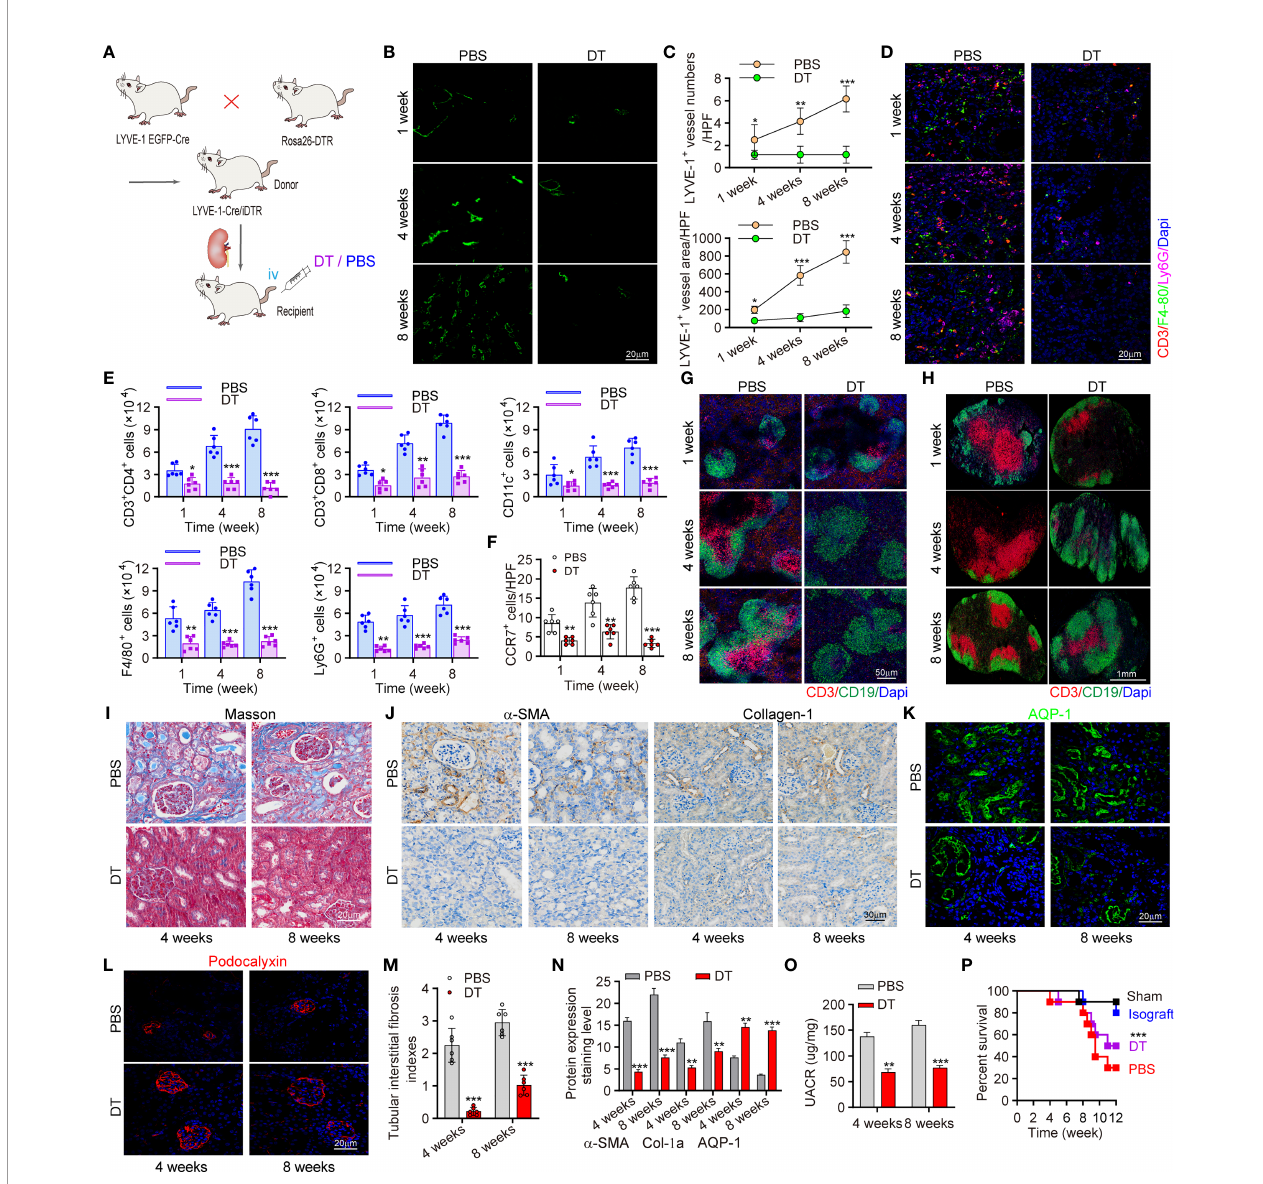
FIGURE 4 | Conditional knockout of LVs attenuated CCR7+ cells expansion and ameliorates allograft function. (A) Scheme showing the establishment of conditional LVs KO mouse model and allograft model. Intervention controls: DT (n=6 mice) or PBS (n=6 mice) injection. (B) Immuno fl uorescence of LYVE-1 labeling intrarenal LVs. (C) Numbers and area of intrarenal LYVE-1 + vessel counted in HPF. (D) Representative immuno fl uorescence images of intrarenal CD3 + , F4/80 + and Ly6G + cells. (E) In fl ammatory cells in fi ltration in kidneys analyzed by fl ow cytometry. (F) Visual counting of CCR7 + cells with confocal microscopy. (G, H) Immuno fl uorescence of B cells and T cells in spleen (left) and RDLN (right). (I) Masson staining of renal tissues. (J) The expression of a -SMA and collagen-1 assessed by immunohistochemistry. (K, L) Immuno fl uorescence of AQP-1 and Podocalyxin. (M) The assessment of tubular interstitial fi brosis indexes. (N) Quantitative analysis of fi brosis – related protein expression. (O) Changes of UARC in kidney transplant mice. (P) Precent survival of recipient mice in different groups. *P < 0.05, **P < 0.01, ***P < 0.001. Values are mean ± SEM. iv, intravenously; DT, diphtheria toxin; RDLN, renal draining lymph node; AQP,